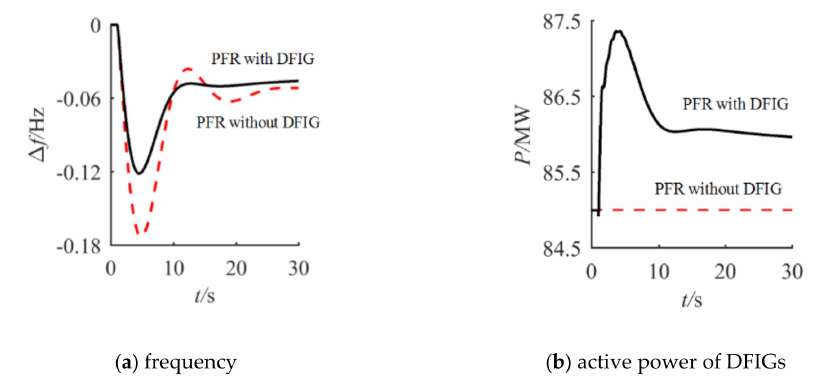
Figure 10. Simulation results with a loss of 23 MW generation, ( a ) for system frequency, ( b ) for active power of